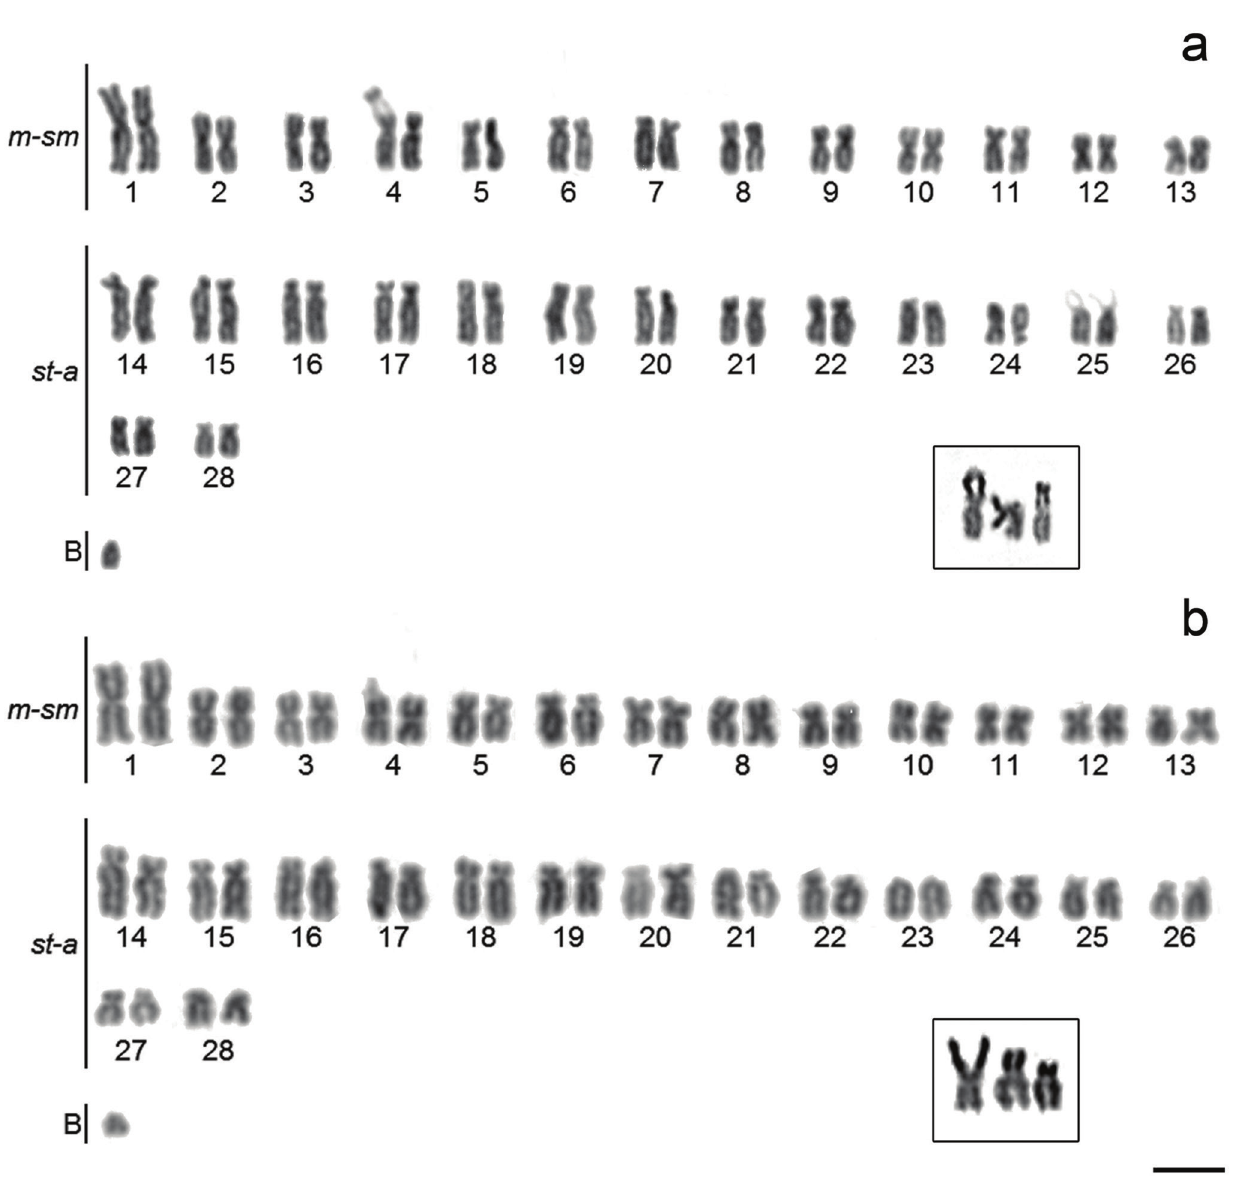
Fig. 1. Callichthys callichthys karyotypes stained by Giemsa: (a) with an acrocentric B chromosome and the third NORs bearing chromosome (interstitial) and (b) with the ill-defined acrocentric B chromosome and the third NORs bearing chromosome (terminal). The bar represents